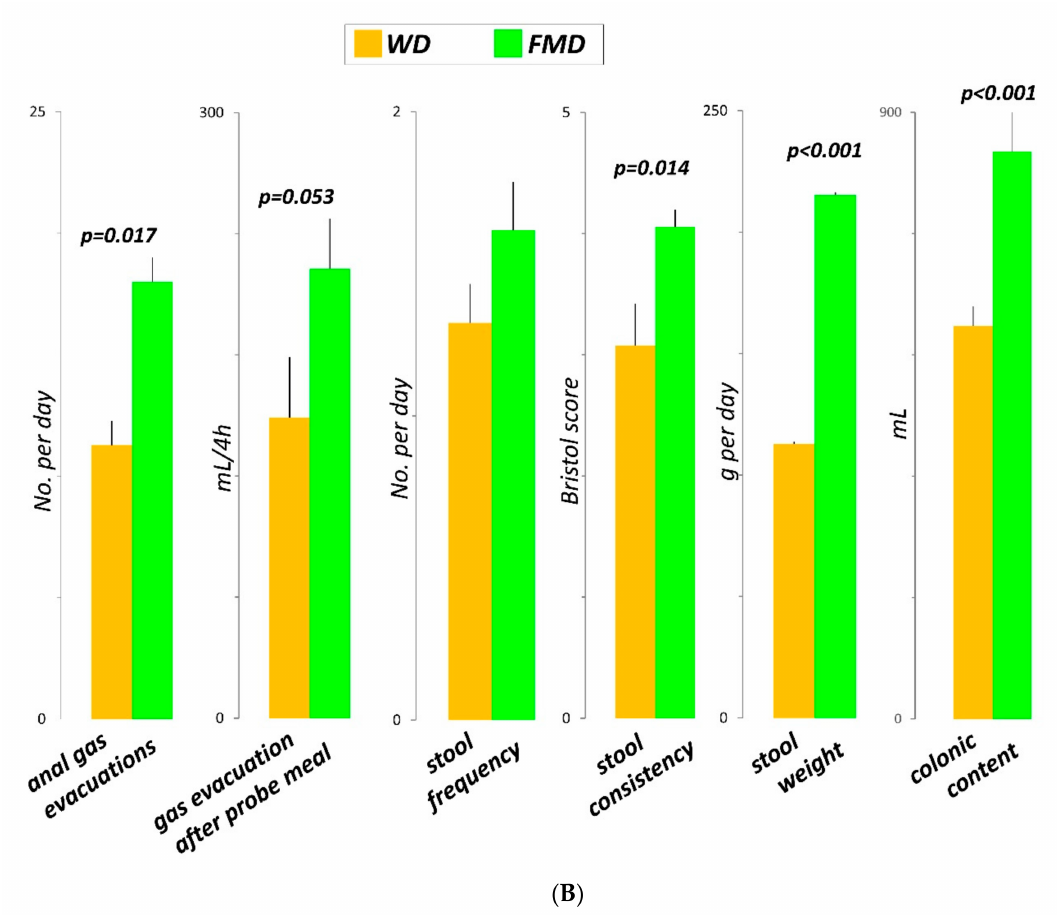
Figure 2. ( A ) Sensations measured by daily questionnaires during the last 2 days of the evaluation periods ( n = 18). Data are average of 2 consecutive days. ( B ) Physiological parameters measured during the last 2 days of the evaluation periods. Values of number of daytime anal gas evacuations, number of bowel movements, Bristol stool form scale and faecal weight are average of 2 consecutive days; volume of gas evacuated during 4 h after a probe meal, and colonic content measured only once ( n =